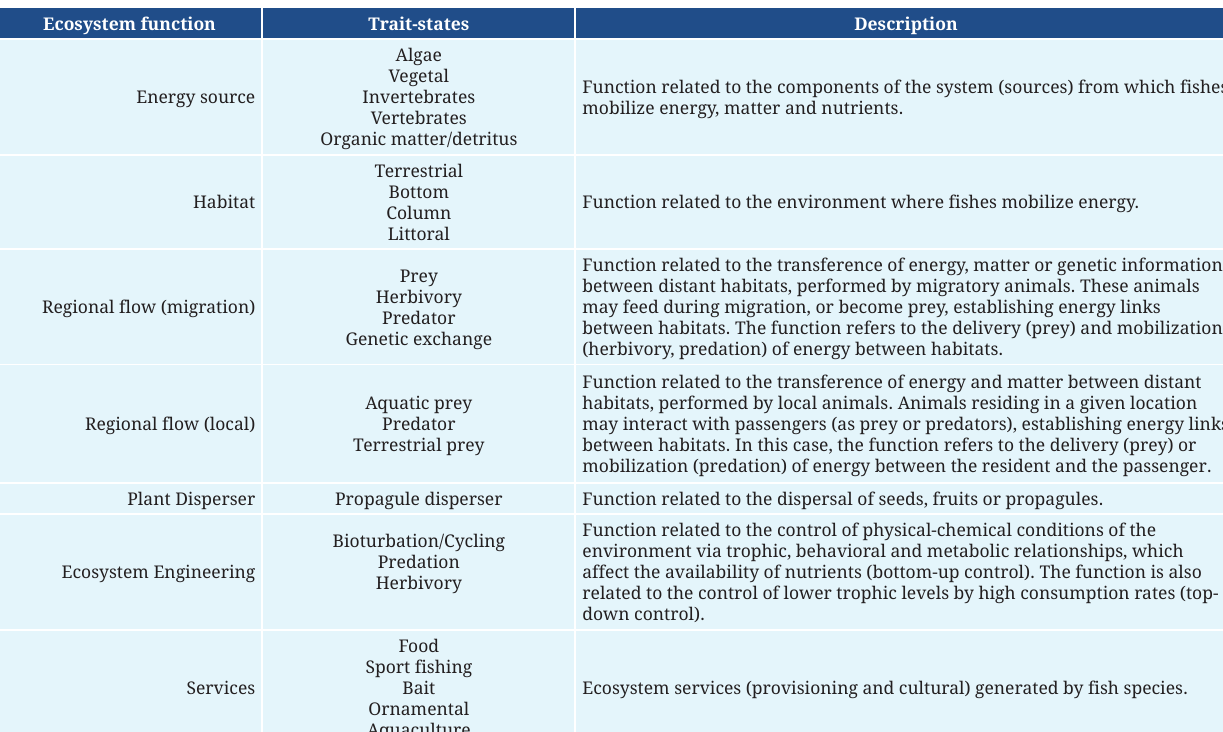
TABLE 1 | Ecosystem functions generated by fish populations considered in the present study. We defined a number of trait-states to describe each function, which were then assigned to each fish